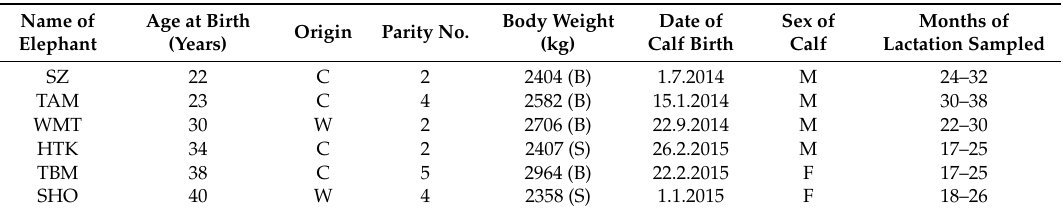
Table 1. Details of Asian elephant cows sampled from the Nat-pauk elephant camp, West Katha Timber Extraction Area in